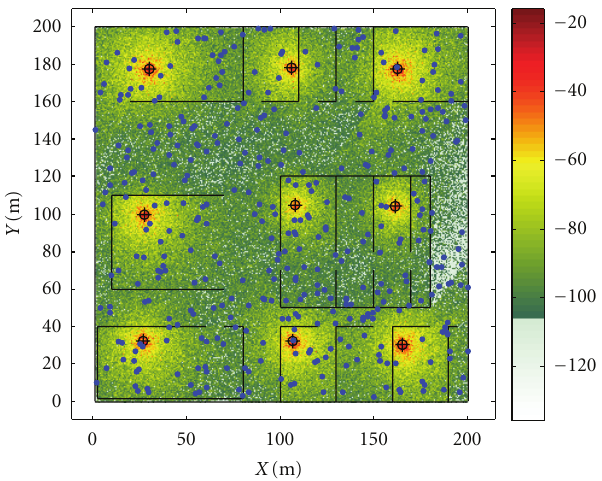
Figure 10: Optimized femtocells coverage when highest weight is given to minimize coverage gaps.